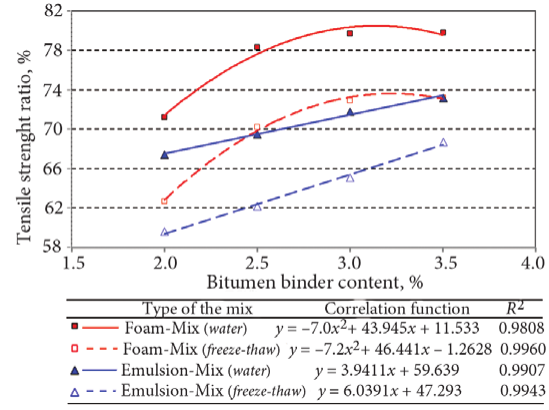
Fig. 8. Relationship between the type and amount of binder in the road base mixes and tensile strength ratios after curing in water ( TSR water ) and after thaw-freeze cycles ( TSR freeze-thaw ) Table 3. Mean indirect tensile strengths of Foam-Mix and Emulsion-Mix samples depending on the bitumen binder content Feature Indirect tensile strengths, MPa Tensile strength ratio,